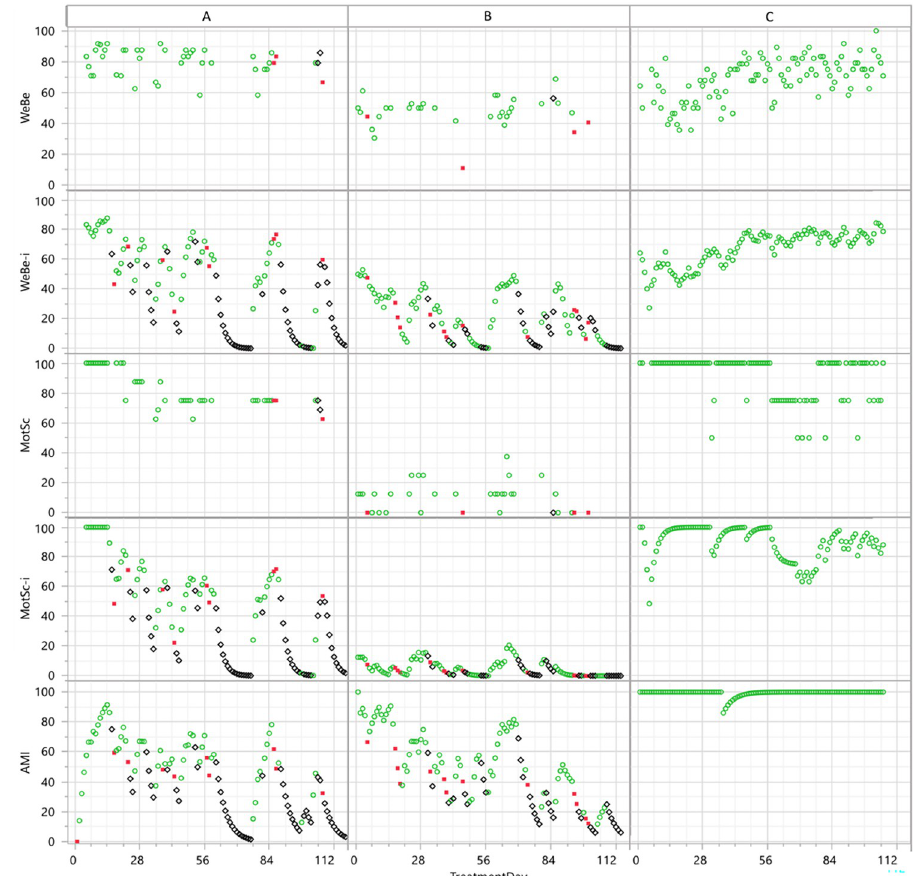
Fig 2. Depicting the clinical course of patients using wellbeing and motivation/self-confidence data. The average/ digital biomarker view of wellbeing (WeBe/WeBe-i), motivation/self-confidence (MotSc/MotSc-i), and Addiction Monitoring Index (AMI) data for 3 patients (A-C) as time series during 4 months (x-axis = Treatment day). Symbols: Green circle = no alcohol detected; Red square = alcohol detected; Black diamond = all breathalyzer tests omitted.